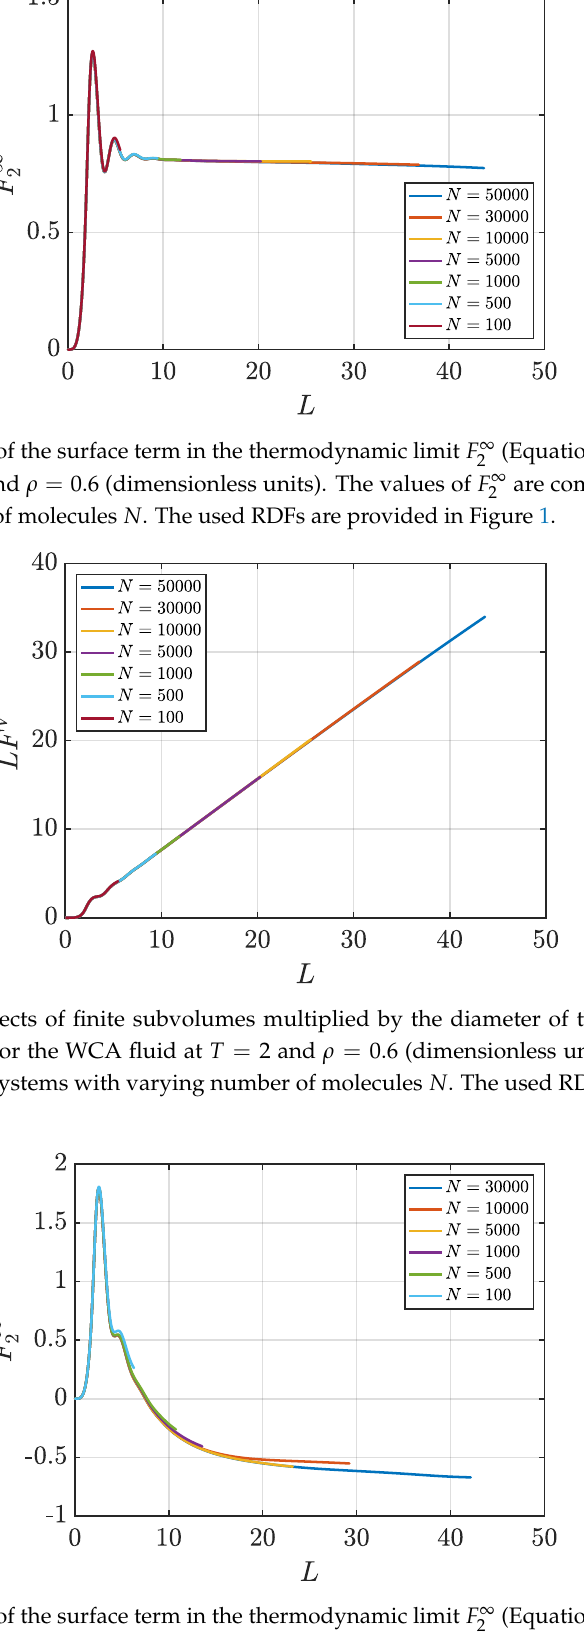
(Equation (11)) vs. L for the 2 are computed for systems with 2